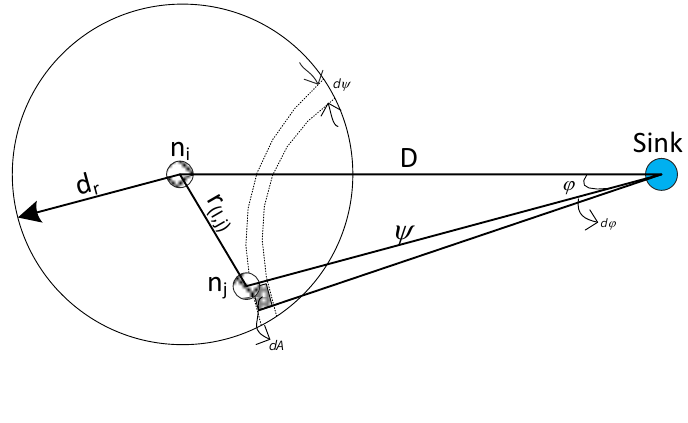
Figure 9. Reference model used for